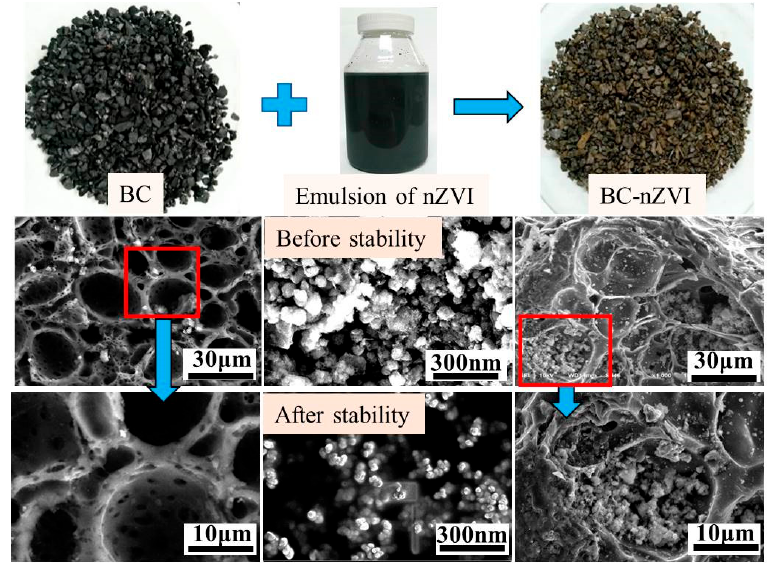
Figure 2. Macrographs and SEM micrographs of biomass-activated carbon (BC), nanoscale zero valent iron (nZVI) particles, and BC-nZVI.